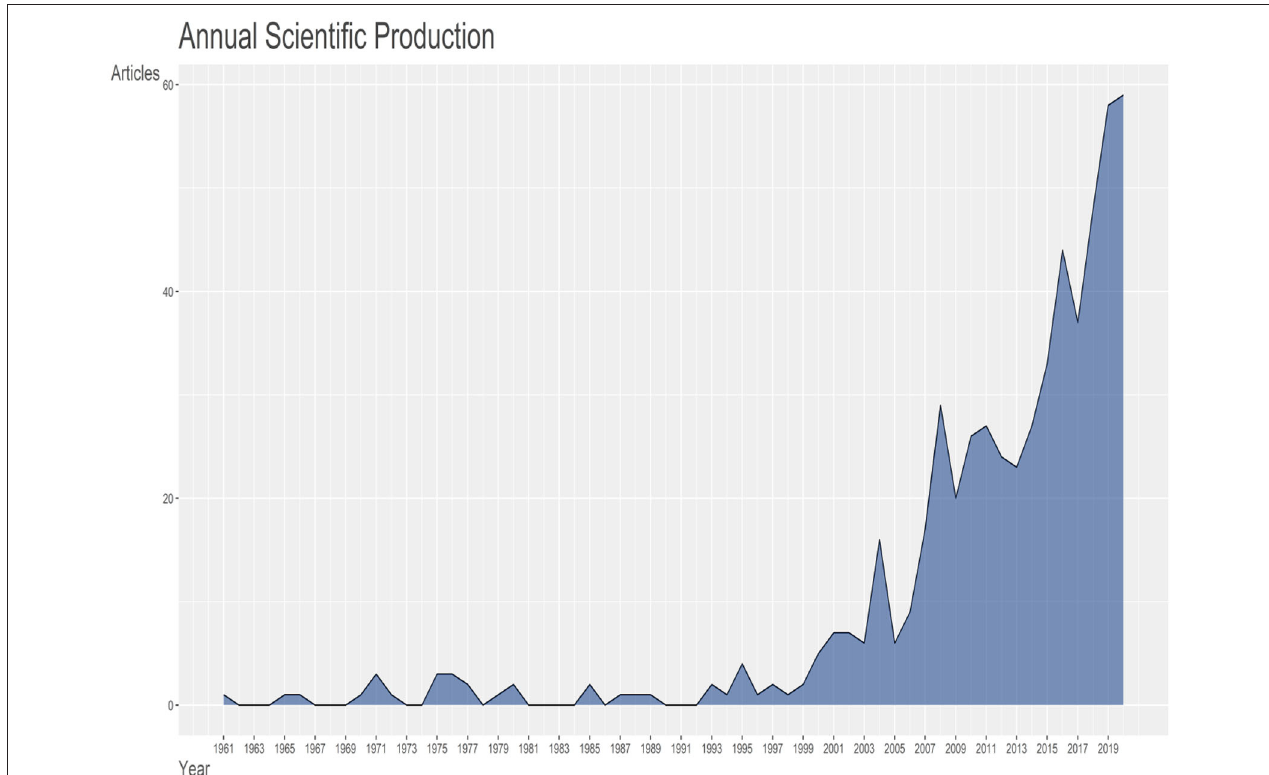
FIGURE 3 | Trends of annual scientific publications (from 1961 to 2020) in citrus waste and animal feed research with an annual growth rate of 10.20%. Citrus waste and animal feed research studies showed several fluctuations (downward and upward trends) in research outputs between 1961 and